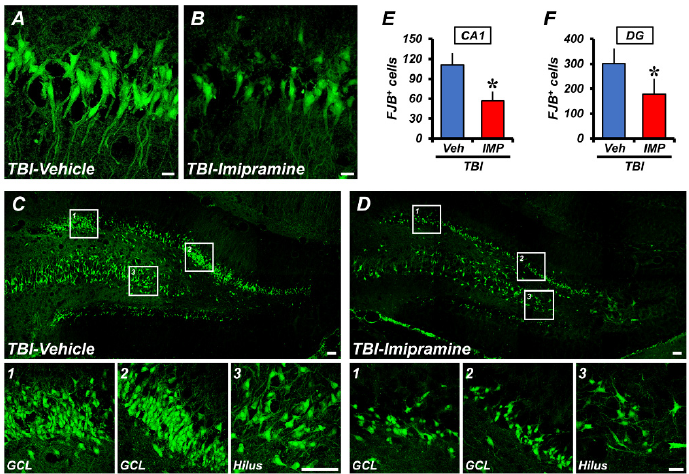
Figure 2. Imipramine treatment reduces hippocampal neuron death 24 h after TBI. ( A , B ) Representative fluorescence images showing degenerating neurons stained with Fluoro-Jade B (FJB) in hippocampal CA1 regions after TBI. Scale bar = 10 µm. ( C , D ) Representative fluorescence images showing degenerating neurons stained with FJB in hippocampal DG (granular cell layer and hilus) regions after TBI. Scale bar = 50 µm. ( E , F ) Quantification of number of degenerating neurons in TBI- vehicle and TBI-imipramine groups. Data are mean ± SEM; n = 6 from each TBI group. * p < 0.05 vs. vehicle-treated TBI group.